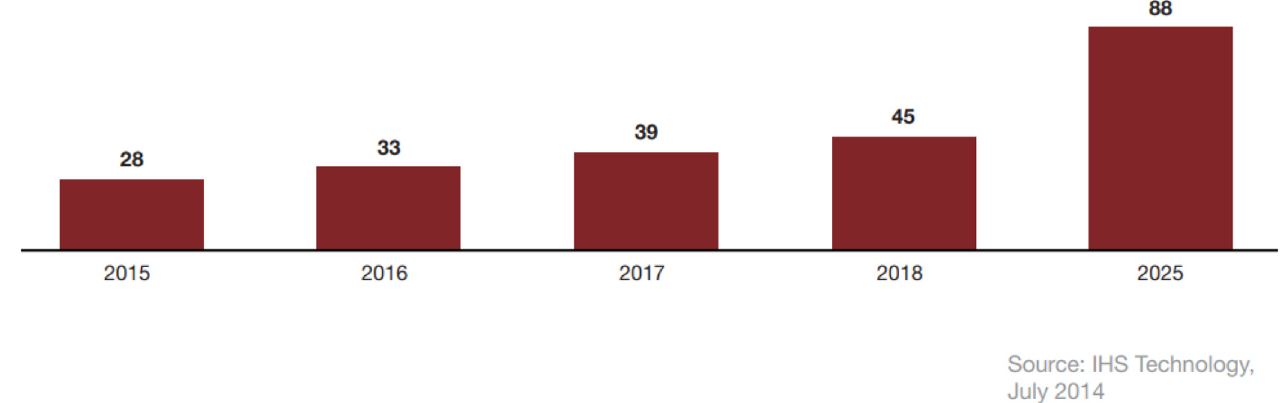
Fig. 12. The future growth of smart cities [9].